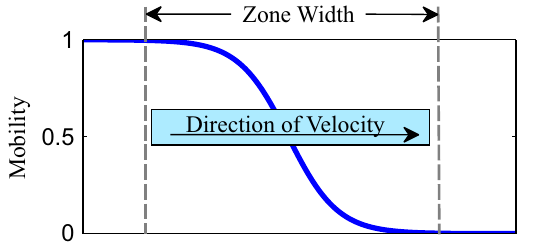
Figure 1. Simulations of zone annealing are performed with a spatiotemporal block copolymer mobility expressed in Eq. (5). As the thermal zone moves across the sample, the local mobility increases from values of zero to